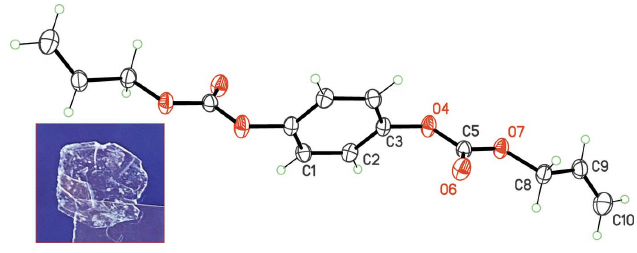
Figure 1 Molecular structure of the title compound. Non-H atoms are drawn at the 30% probability level. Non-labelled atoms are generated by the symmetry operation 1 (cid:5) x , 1 (cid:5) y , (cid:5) z . The inset is the raw material as obtained from the synthesis. The edges of the hexagonal flake have dimensions of ca 5 mm.